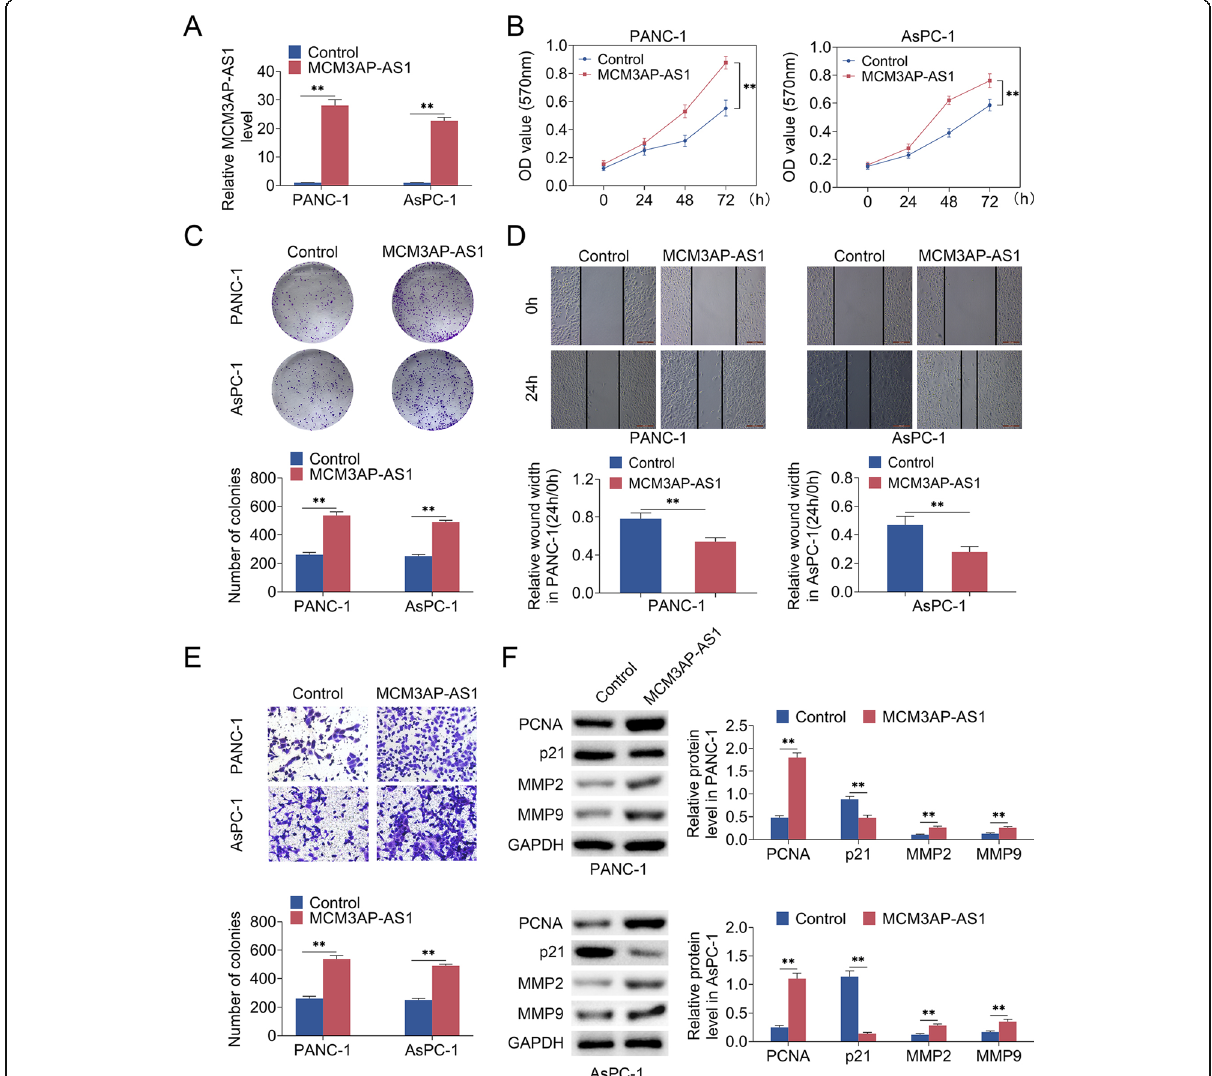
Fig. 2 MCM3AP-AS1 promoted cell growth and invasion in PC cells. a qRT-PCR identified MCM3AP-AS1 level. b MTT assay detected cell proliferation. c Clone formation ability was detected using clone formation assay. d , e Transwell assay and wound healing assay examined cell invasion and migration. Scale bar: 50 μ m. f PCNA, MMP2, MMP9 and p21 protein levels were examined using western blot analysis. n = 3. (**, p <